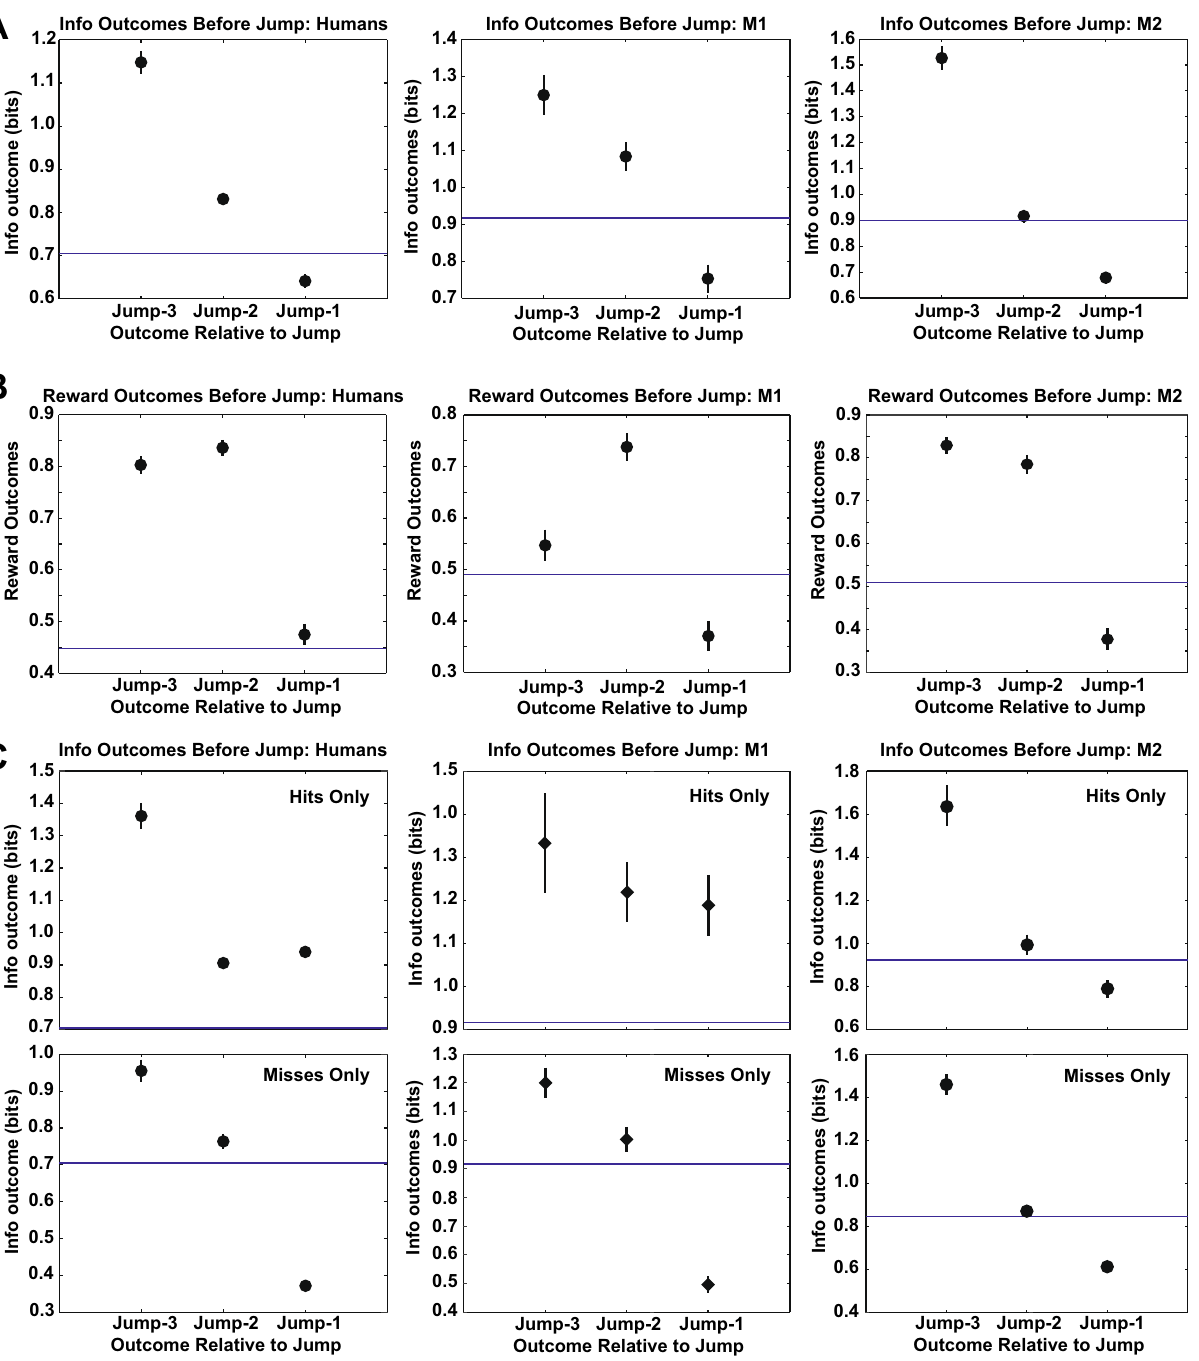
Jump-3 Jump-2 Jump-1 Outcome Relative to